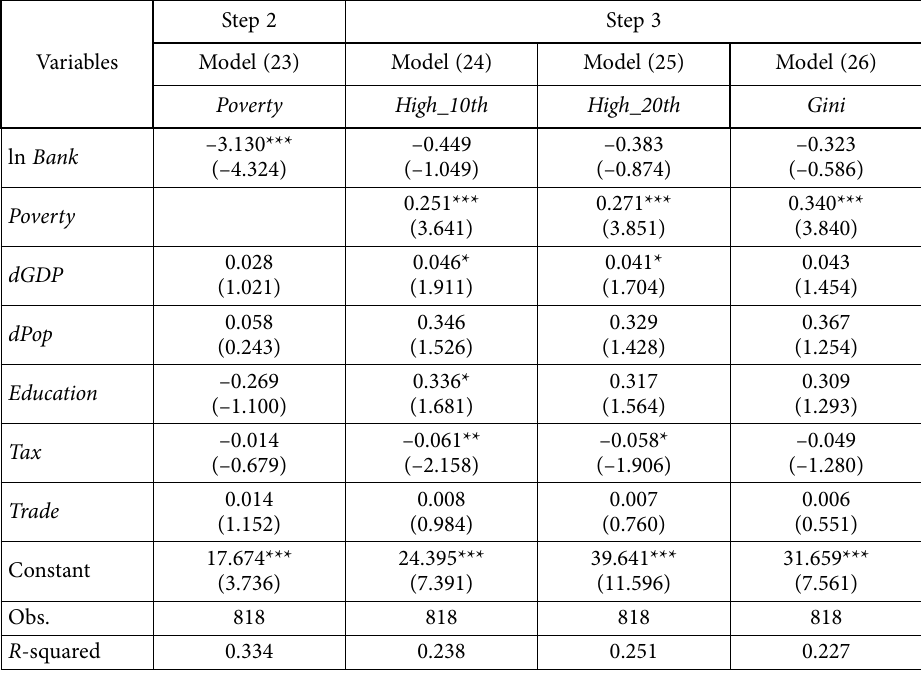
Table 7. Verification of the intermediary